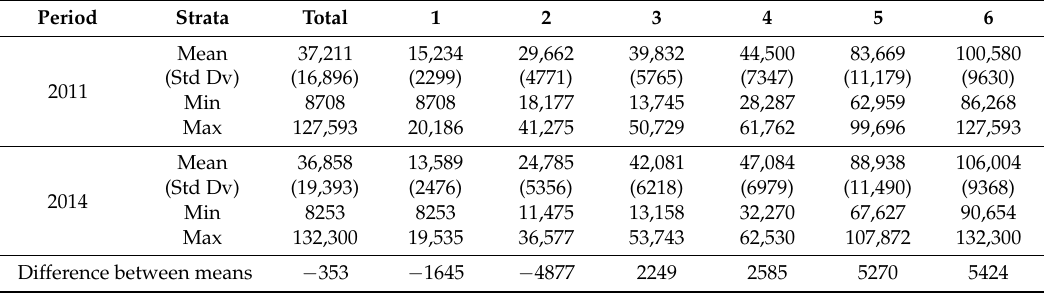
Table 4. Descriptive statistics of average monthly rates paid ($COP/month) per household in